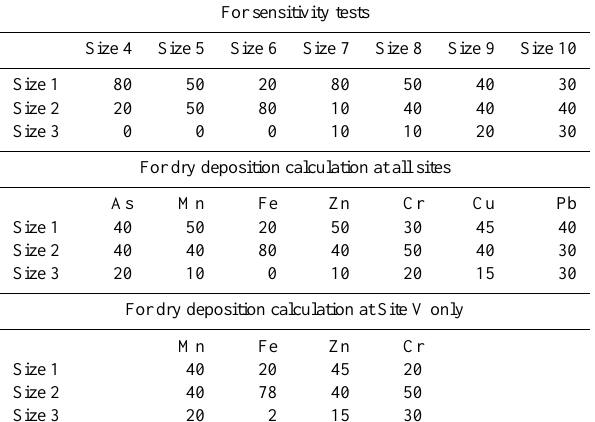
Table 2. Different combinations of Size 1, Size 2, and Size 3 (in percentage) for V d sensitivity tests (Size 4 to Size 10) and for V d and F calculations of seven metal species. Size 1, Size 2 and Size 3 are three single lognormal size distributions representing PM 2 . 5 , PM 2 . 5 − 10 , and PM 10 + , respectively, as shown in Fig.